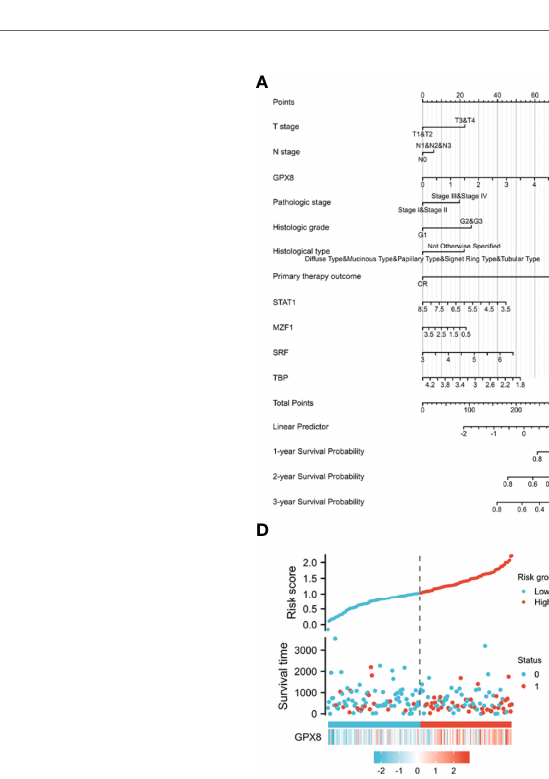
FIGURE 6 | A quantitative method to predict the 1-, 2-, and 5- year OS in STAD patients. (A) A nomogram for predicting the probability of 1-, 3-, and 5- year OS for STAD patients. (B) Calibration plots of the nomogram for predicting the probability of OS at 1, 2, and 3 years. (C) The ROC curve of the GPX8 and its transcription factors in over-survival time. OS, overall survival. (D) GPX8 expression distribution and survival